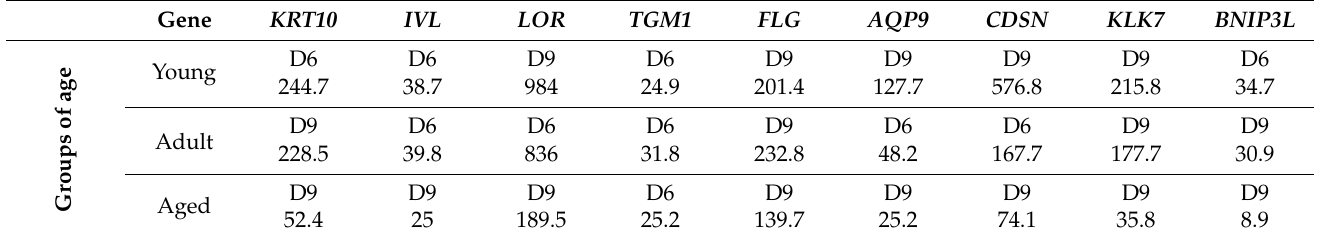
Table 1. Moment and intensity of the maximal expression levels of differentiation markers in human keratinocytes (relative to